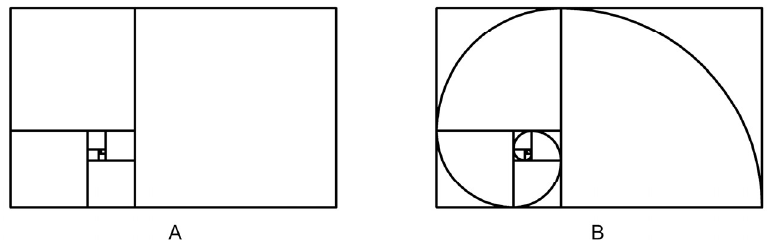
Figure 7. ( A ) Fibonacci sequence of boxes through 10 iterations and ( B ) the sequence with quarter arcs forming a spiral. To support legibility, line thicknesses are increased compared to the analysed images.